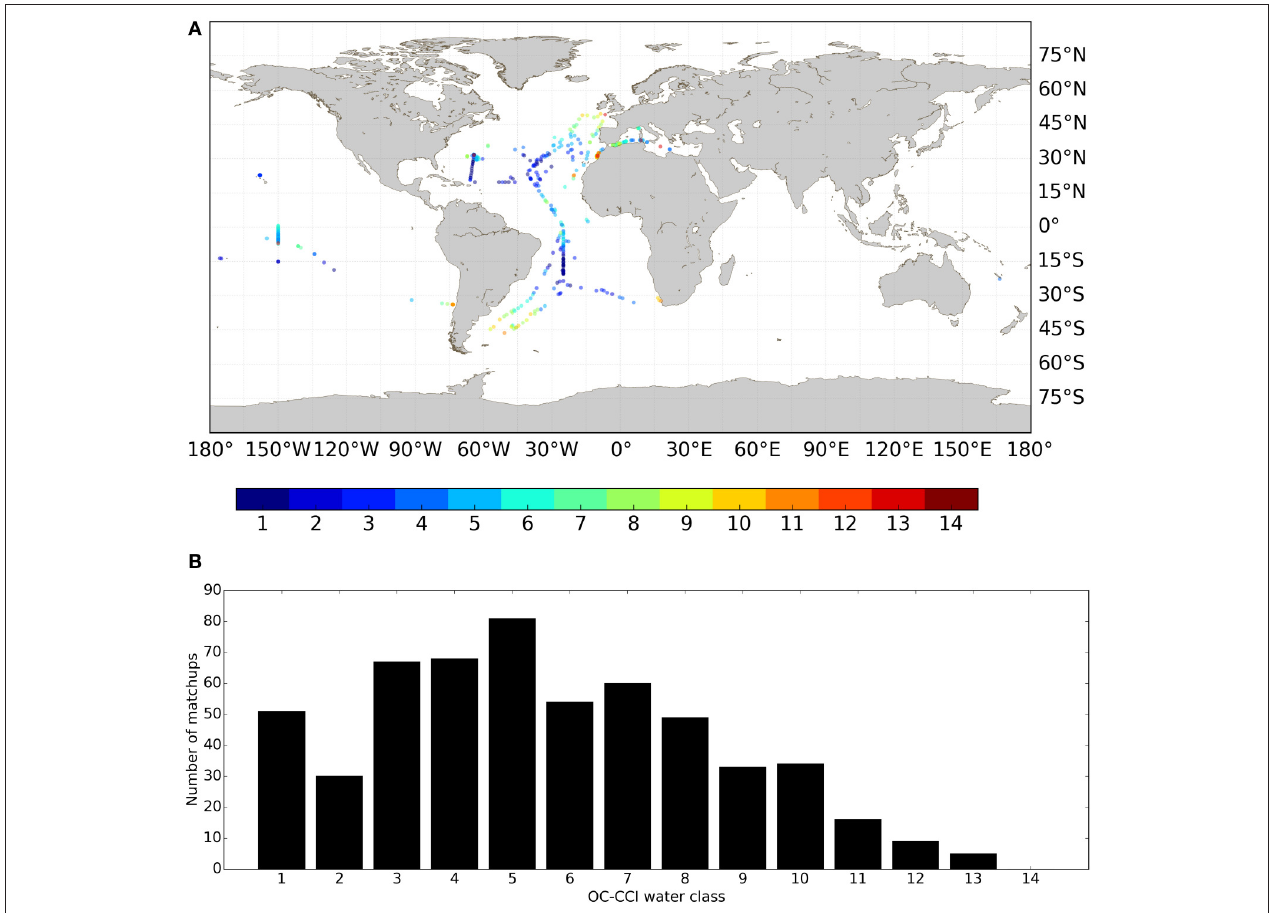
FIGURE 5 | Distribution of the C phy from the match-up dataset per optical water class. (A) Geographical distribution. (B) Number of data per optical water class.